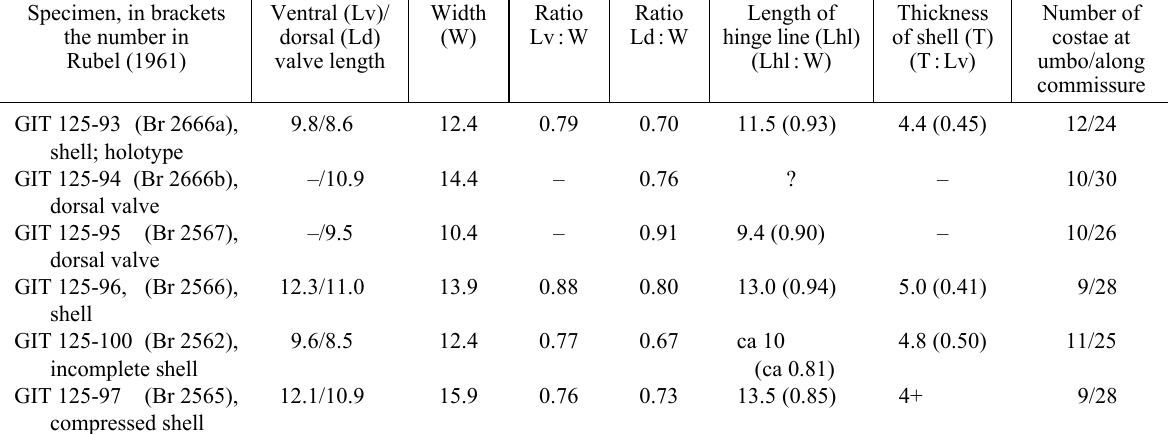
Table 1. Dimensions (in millimetres) of Leoniorthis rubeli sp. nov. Ratios of measurements in brackets Specimen, in brackets the number in Rubel